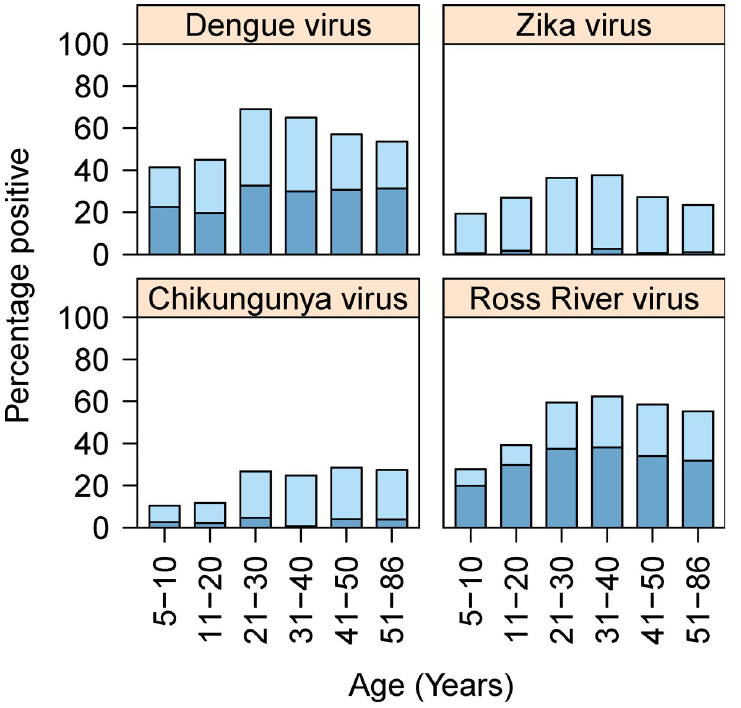
Fig 4. The seroprevalence of flaviviruses and alphavirus across different age groups in the Solomon Islands. The darker blue colour represents samples that were positive for that particular virus alone. The lighter blue colour represents samples that were positive for both of the flaviviruses (dengue and Zika) or both of the alphaviruses (chikungunya and Ross River virus). https://doi.org/10.1371/journal.pntd.0009848.g004 Seropositivity varied across study sites for all arboviruses tested (Fig 5). The prevalence of antibody positive individuals to one or more of the flaviviruses (either DENV or ZIKV) and the alphaviruses (CHIKV or RRV) was highest in the villages of Guadalcanal, Honiara and West Malaita (Figs 2 and 3). In East Malaita and Isabel, the prevalence of antibodies recognis- ing flaviviruses and alphaviruses was relatively lower than the other sites. The prevalence of antibody positive individuals increased by age categories, peaking in the 21–30 years group for DENV and 31–40 years for ZIKV and RRV (Fig 4). Within the flaviviruses, there was signifi- cantly more residents that were solely seropositive for DENV compared with ZIKV ( χ 2 = 309.71, df = 1, p < 0.0001). Within the alphaviruses, there was significantly more residents that were solely seropositive for RRV compared with CHIKV ( χ 2 = 300.55, df = 1, p < 0.0001). Table 2. Final set of nested models evaluated to determine which best predicted the seroprevalence of flavi- and alphaviruses. Model df